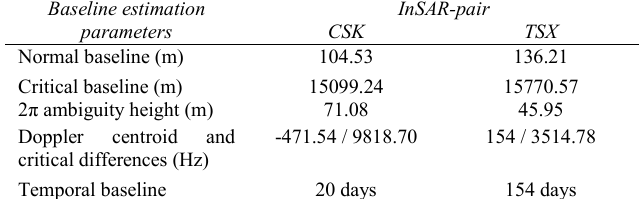
Table 2. Baseline estimation